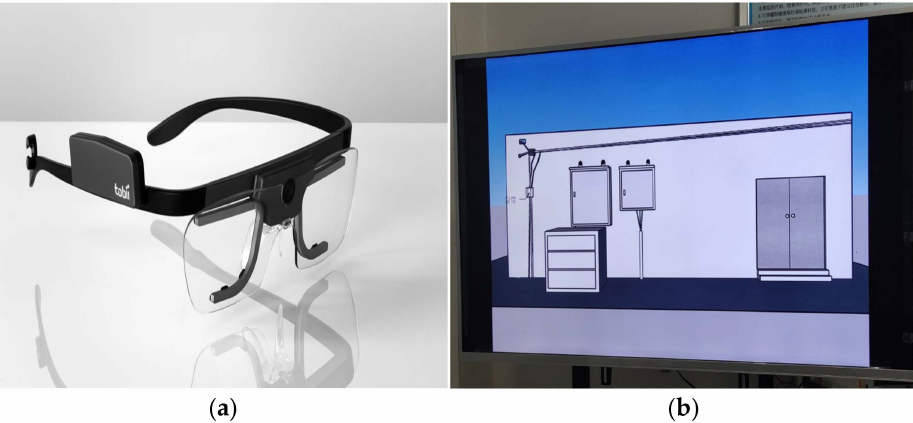
Figure 3. Laboratory equipment. ( a ) Tobii Glasses 2 Wearable Eye Tracker, ( b ) Experimental Electronic Display